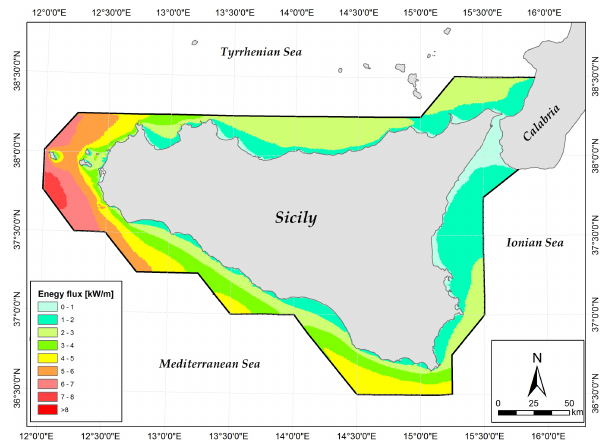
Figure 8. Distribution of the average wave energy flux per unit crest length within the computational